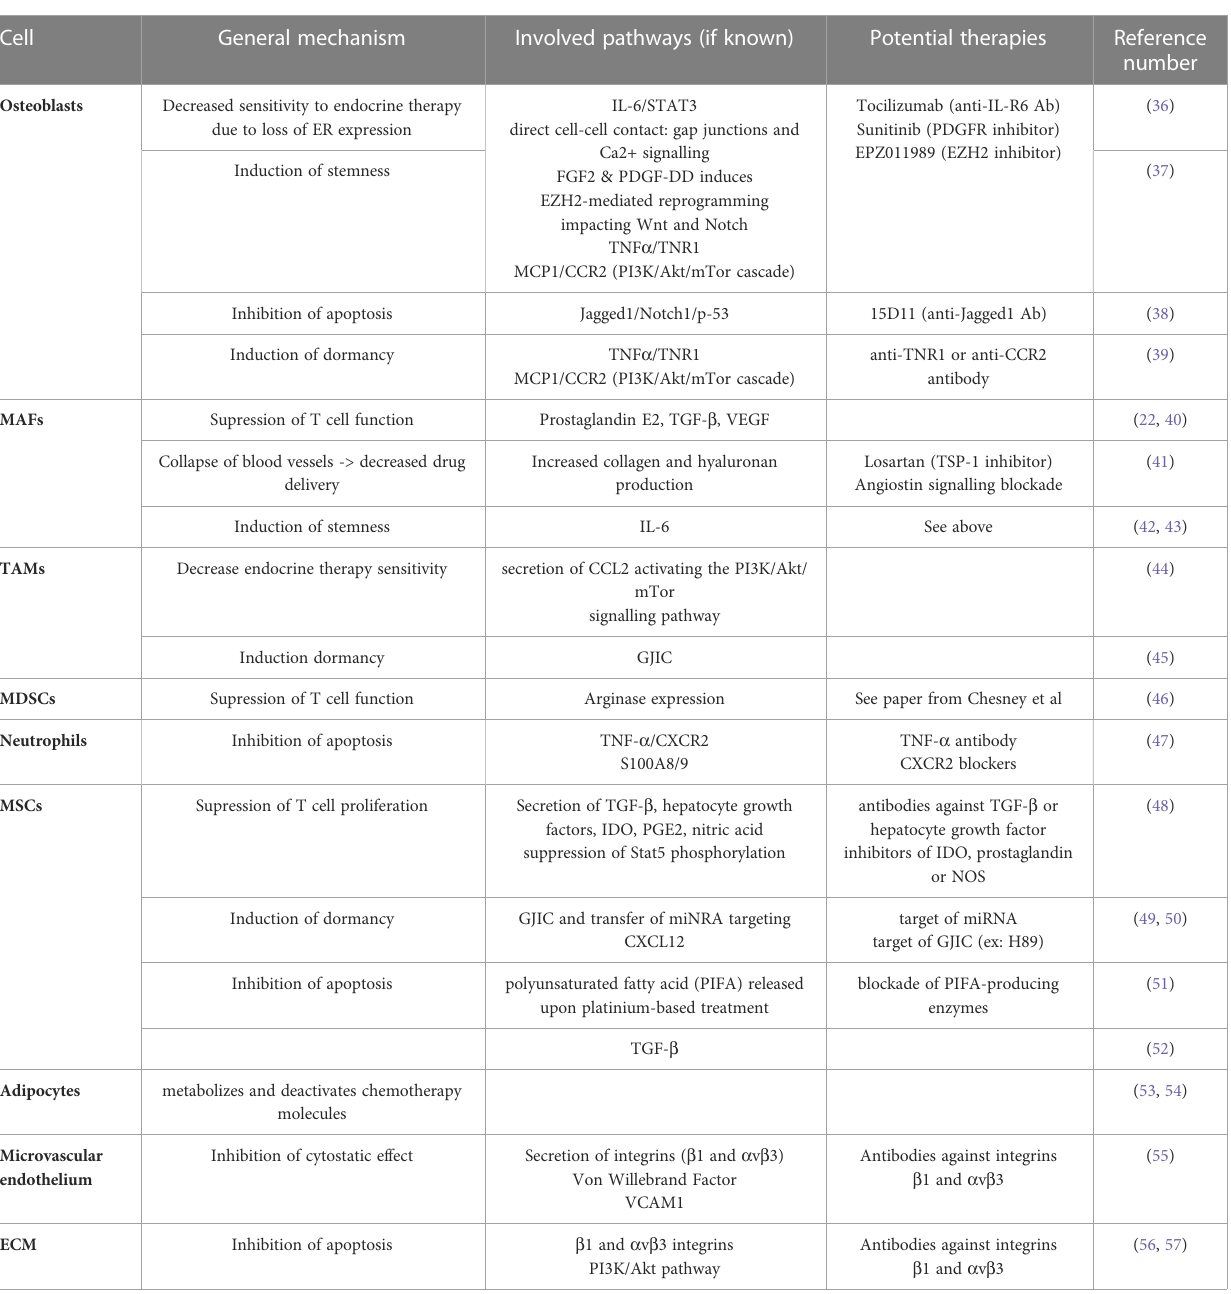
TABLE 2 Biological mechanisms and pathways involved in metastatic breast cancer drug